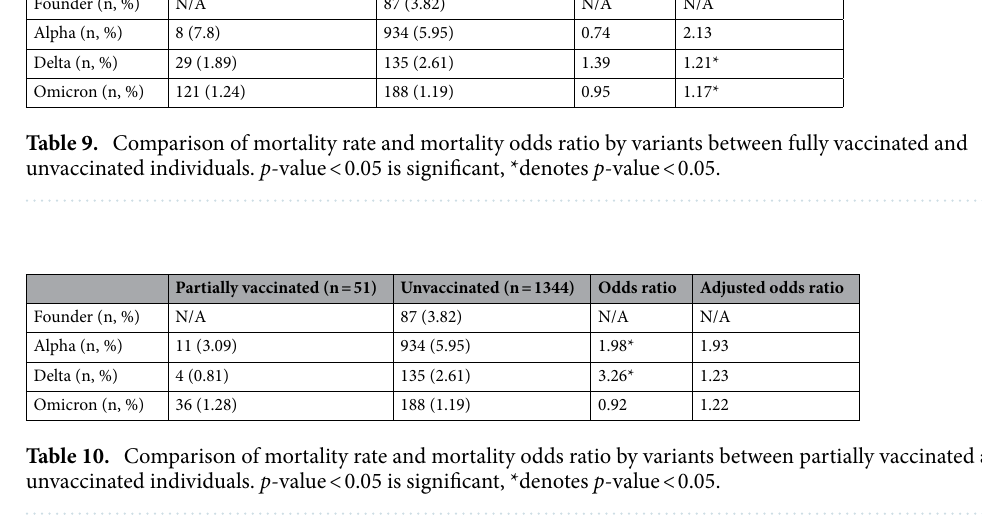
Fully vaccinated (n = 158) Unvaccinated (n = 1344) Odds ratio Adjusted odds ratio Founder (n, %)